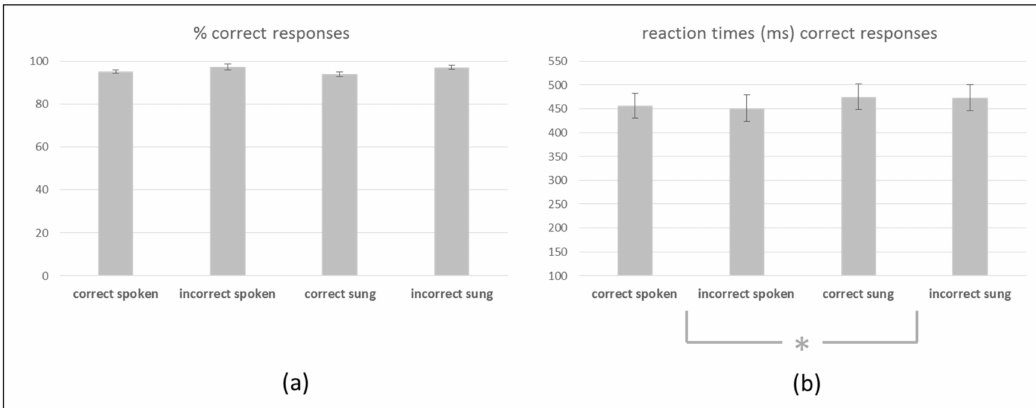
Figure 2. Behavioral data from the correctness judgement task. ( a ) Percentage of correctly answered trials per experimental condition including SEMs. ( b ) Reaction times (in ms) of correctly answered trials per experimental conditions including SEMs. * indicates the significant main e ff ect of modality reflecting longer reaction times for sung compared to spoken sentences.